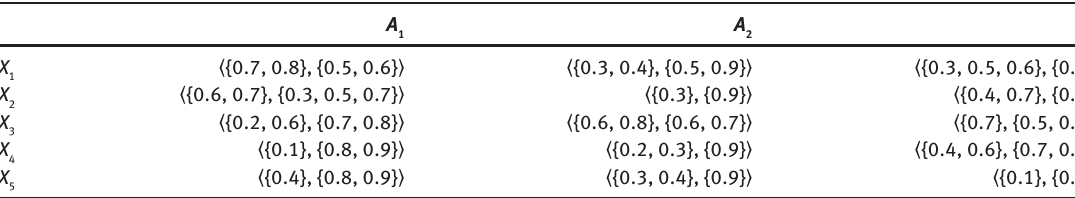
Table 2: Normalized Pythagorean Hesitant Fuzzy Decision Matrix D